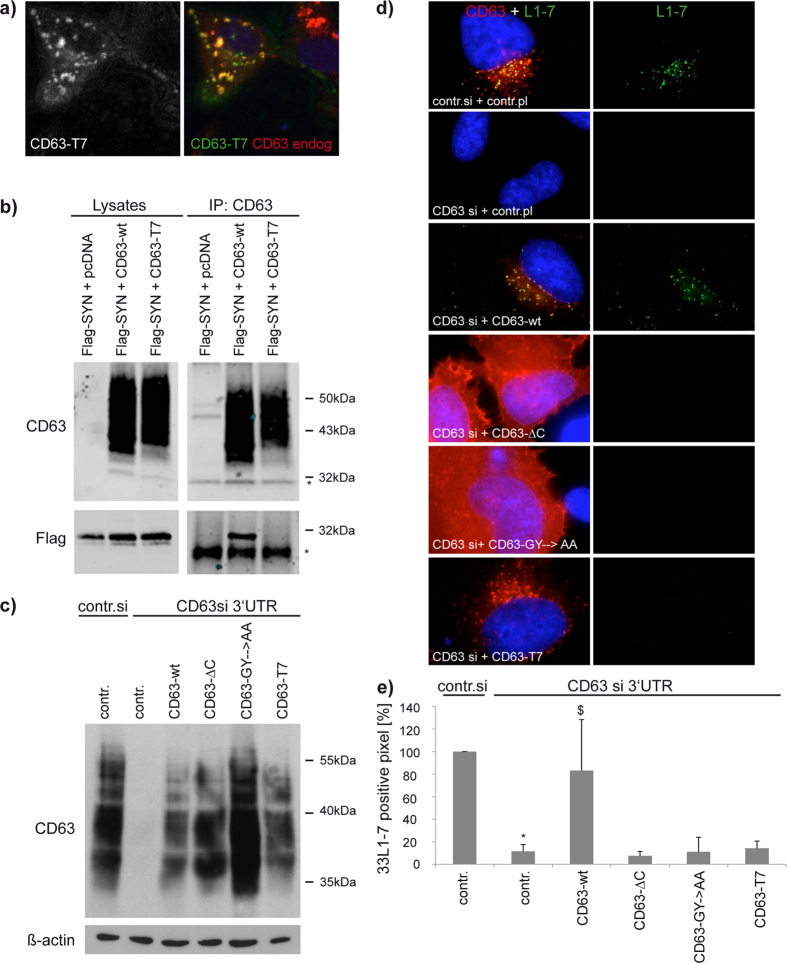
Syntenin-1-binding deficient mutants of CD63 fail to recover L1-7 reactivity.(a) Representative pictures of wild-type (wt) and mutant CD63. Rat1 cells were transfected with a plasmid encoding CD63 mutant T7 (human) and stained with species-specific CD63 antibodies, sc-5275 (human) and AD1 (rat). CD63-T7 mutant (green) colocalises with endogenous rat CD63 (red). (b) CD63-T7 mutant cannot interact with syntenin-1. CHO cells were cotransfected with plasmids encoding flag-tagged syntenin-1 and human CD63 as indicated. Immunoprecipitation was carried out using mouse anti-human CD63 mAb 6H1. Precipitated proteins were detected by Western blotting using rabbit Flag (lower panels) or CD63 antibodies (upper panels). Lysates were loaded as positive controls for transfection. Asterisks mark non-specific bands. (c–e) Recovery of L1-7 reactivity using CD63 mutants. CD63 depleted HeLa cells were transfected with control or mutant CD63 plasmid and infected with HPV16. (c) CD63 mutants efficiently reexpress CD63 after respective knockdown. (d) Shows representative pictures of CD63 and L1-7 double staining in different CD63 mutants. (e) L1-7 reactivity was quantified as in Fig. 2e,f. *P < 0.05 significant decrease compared to control, $P < 0.05 significant increase compared to cells transfected with CD63 siRNA and control plasmid.